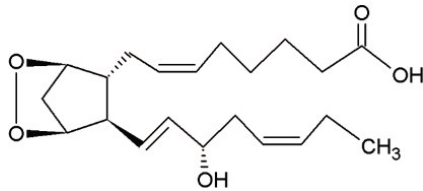
Figure 4. Prostaglandin G 3